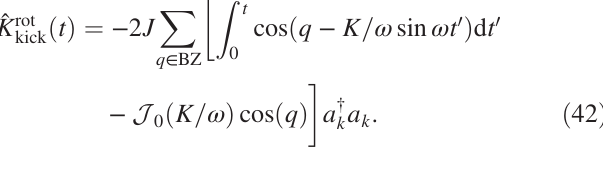
FIG. 14. Top panel: Instability rate as a function of the interaction strength g for ω ¼ 32 J and for two values of the modulation amplitude. As captured by the analytical expression Eq. (36), the instability rate increases linearly with g . Bottom panel: Instability rate as a function of the modulation amplitude K= ω for ω ¼ 32 J and for two values of the interaction parameter g . As captured by the analytical expression Eq. (36), the instability rate increases quadratically with K= ω at low